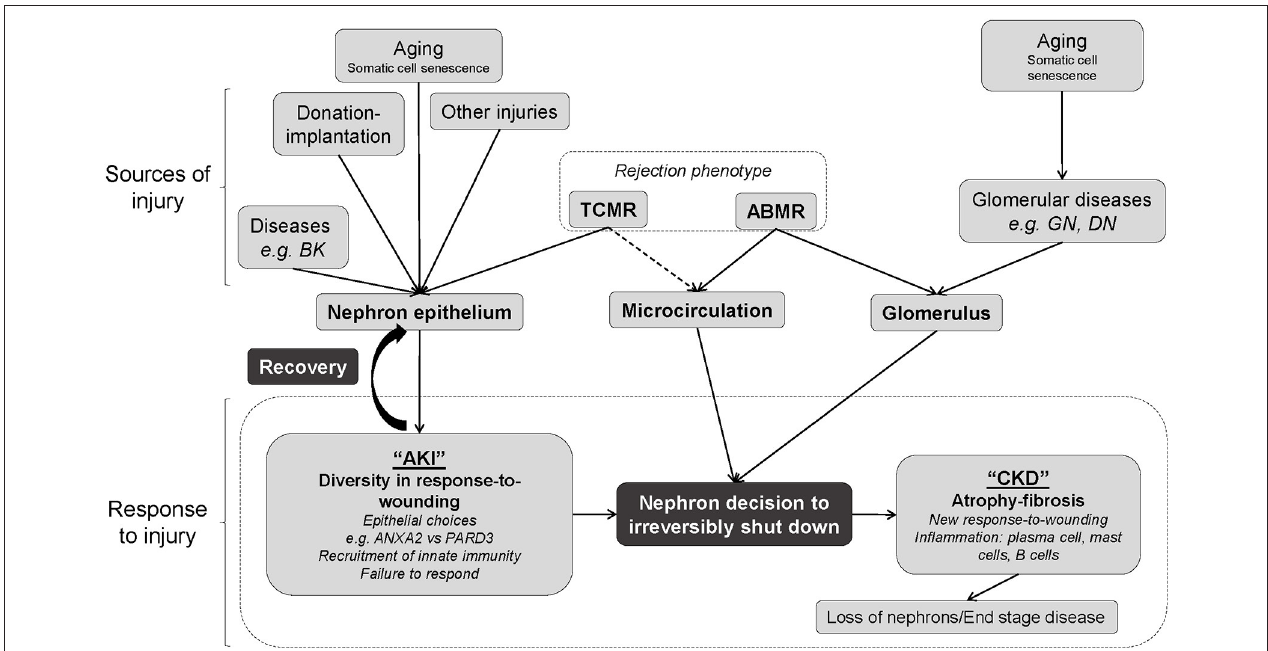
FIGURE 4 | Schematic diagram representing the relationships between sources of injury and response to injury in kidney transplant biopsies based on these analyses. Interplay between sources of injury, pre-existing limitations such as aging, and response to injury by the nephron. There are two routes to irreversible nephron shutdown, namely, the epithelial injury and through glomerulus injury. Epithelial injury should trigger the response-to-wounding, which involves epithelium, matrix, and microcirculation, and evokes innate immunity. Failure to mount a response to wounding and adopting a “PC3”-related response (e.g., PARD3) with minimal inflammation leads to failure to recover. Many sources of injury (separate from and including rejection) interact with the nephron epithelium, producing acute kidney injury (AKI). In this instance, the epithelium can be repaired and the organ can recover, or progress to nephron failure. Alternatively, aging and/or ABMR can contribute to glomerular disease and ABMR can additionally affect the microcirculation, affecting the glomerulus and again causing nephron shutdown, which eventually leads to chronic kidney disease (CKD). If this occurs, a loss of nephrons and end-stage renal disease may occur. Different sources of injury may interact to cause many forms of injury, and injury itself predicts the graft survival while the rejection status does not. Thus, defining the heterogeneity within biopsy injury is an important part of clinical